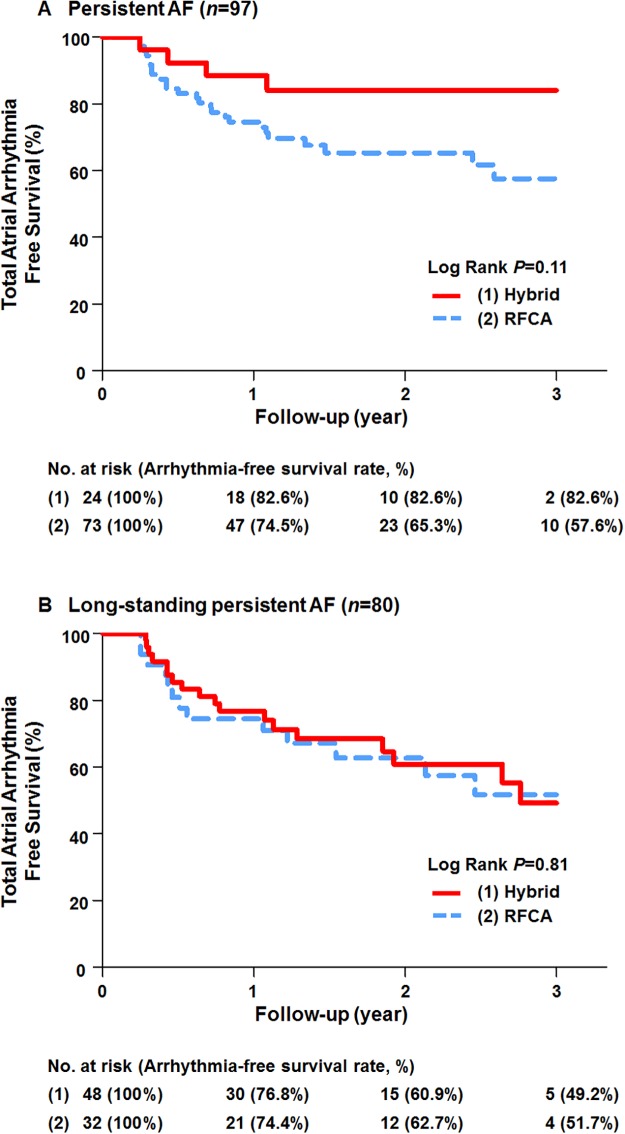
Total atrial arrhythmia-free survival curve by subtype of AF.Comparison of total atrial arrhythmia-free survival rates in patients with (A) persistent AF and (B) long-standing persistent AF. AF, atrial fibrillation; RFCA, radiofrequency catheter ablation.